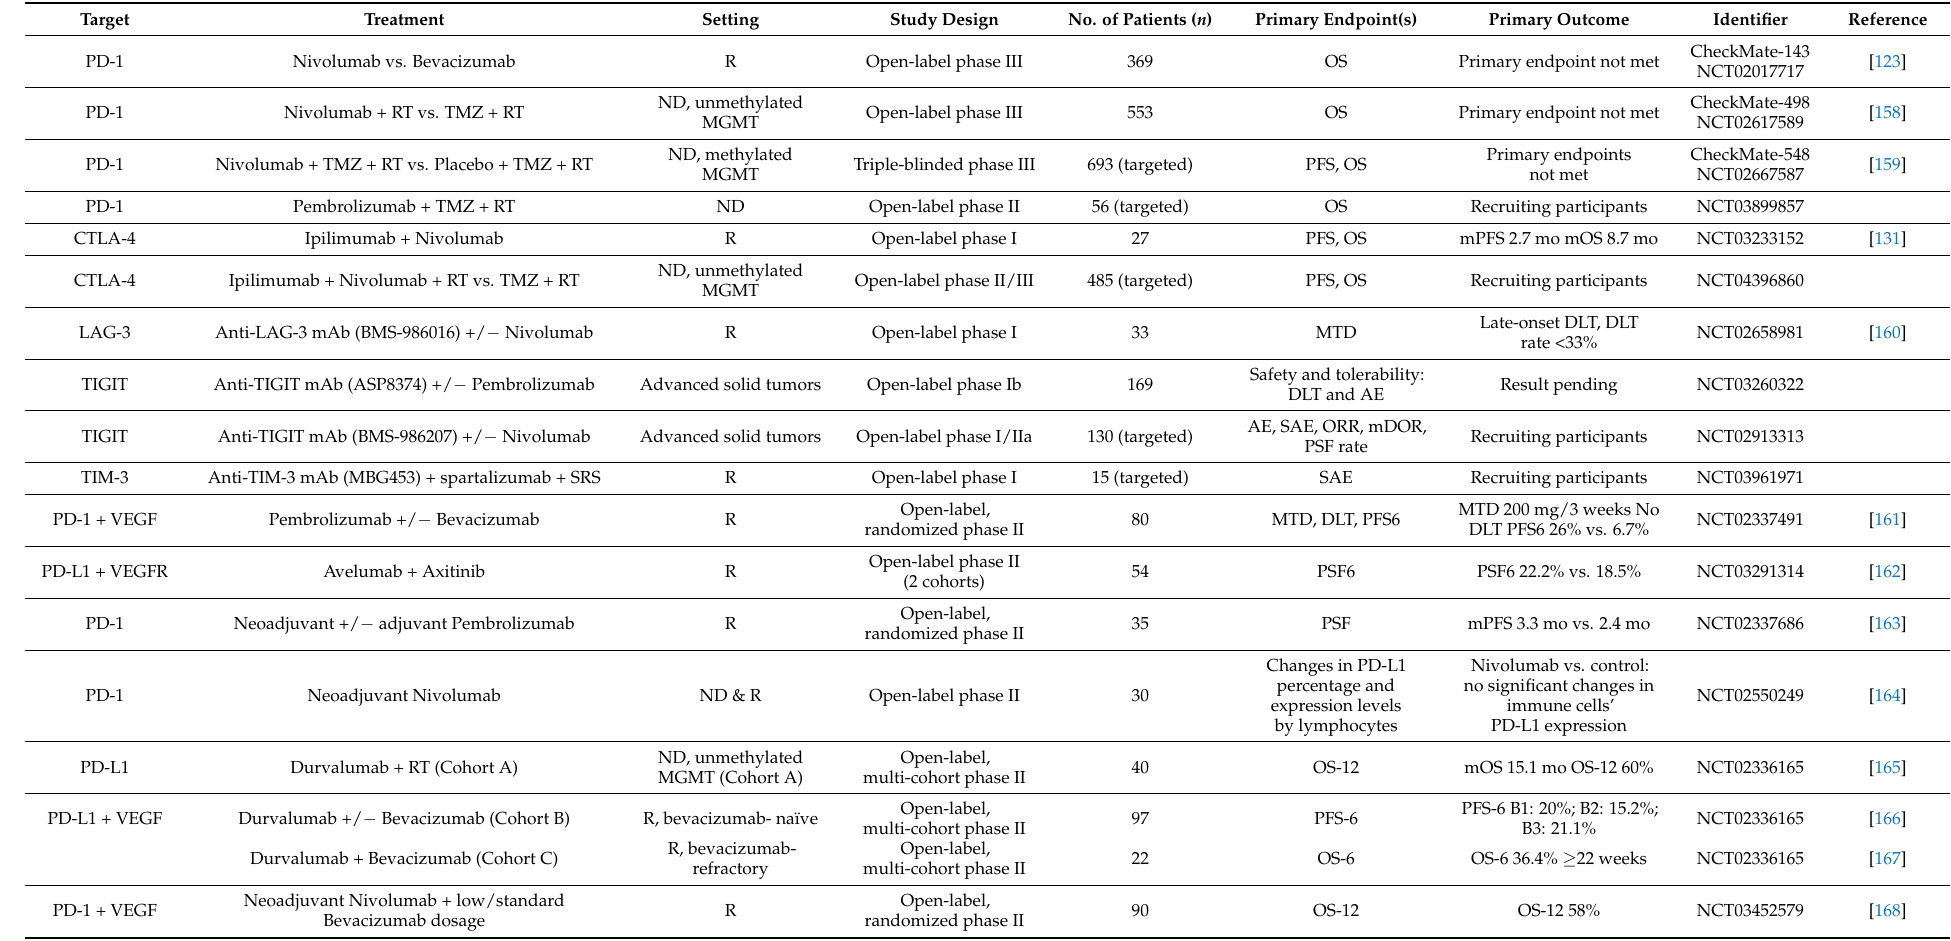
Table 1. Completed and ongoing ICB clinical trials in monotherapies and in combination with antiangiogenic therapy in